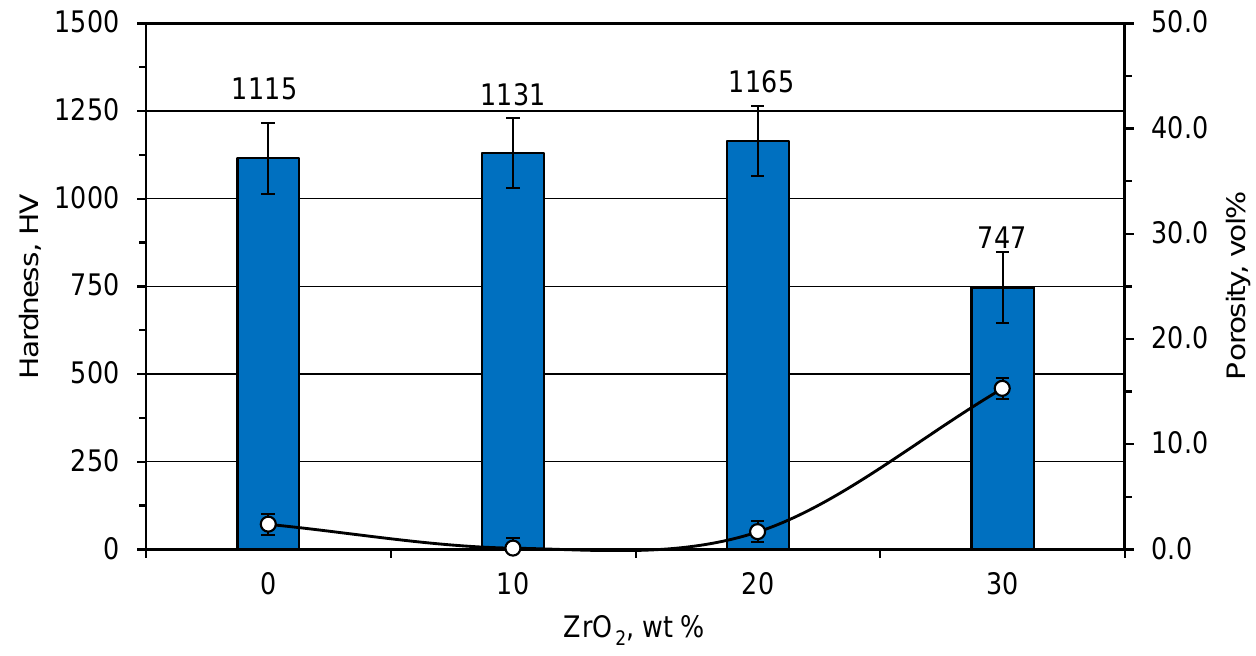
Figure 7. Effect of ZrO 2 additives on the samples’ hardness (bars) and porosity (data ponits) prepared at 234 MPa.